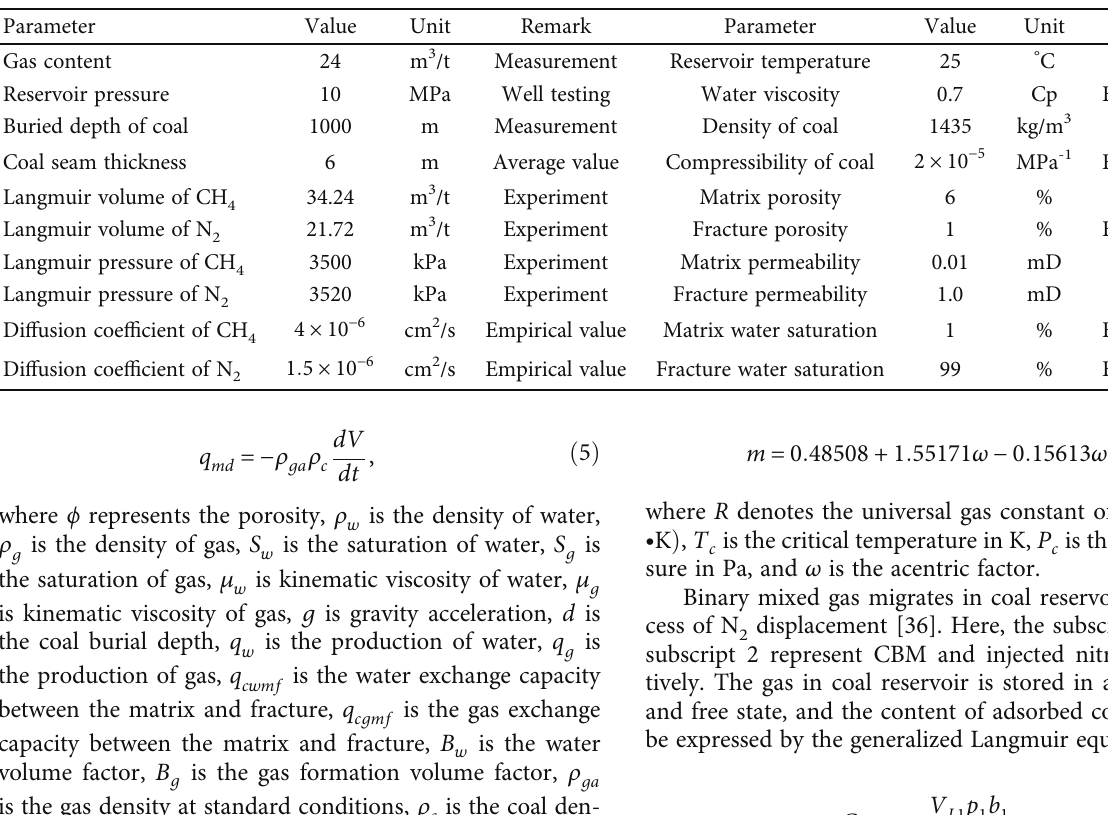
Table 1: Basic parameters used in the numerical